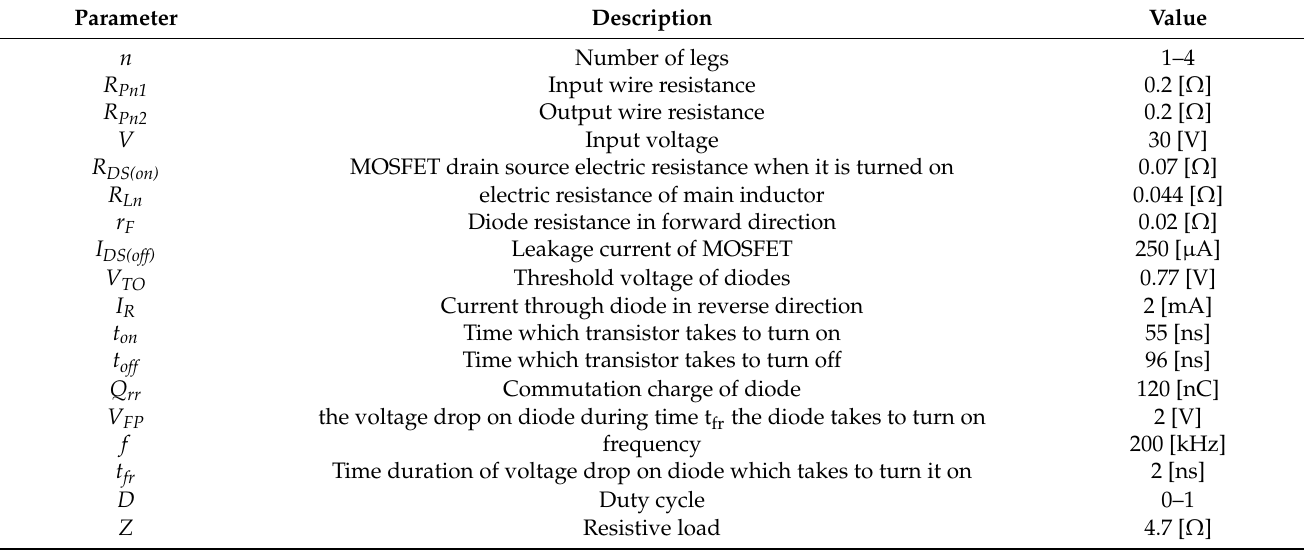
Table 1. Electrical components parameters